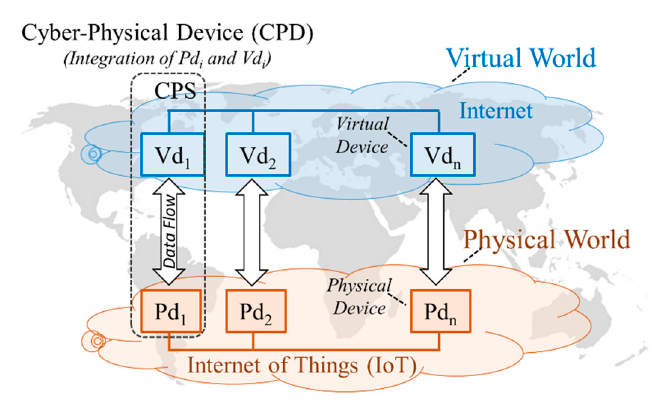
Figure 2. Cyber-physical systems and the Internet of Things.